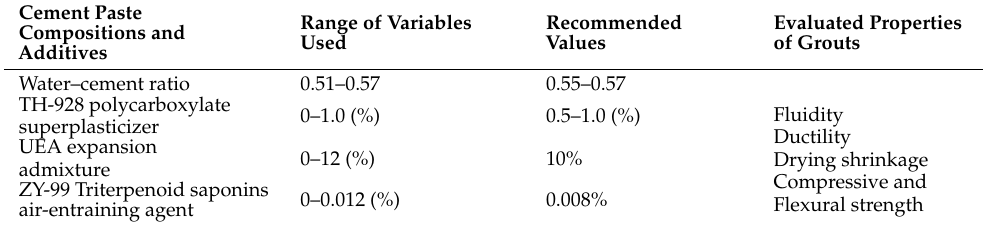
Table 6. The recommended range of additives and w/c ratio for grout composition